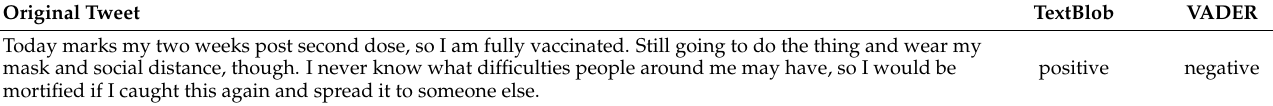
Table 6. Random tweets from Twitter Dataset 2 on social